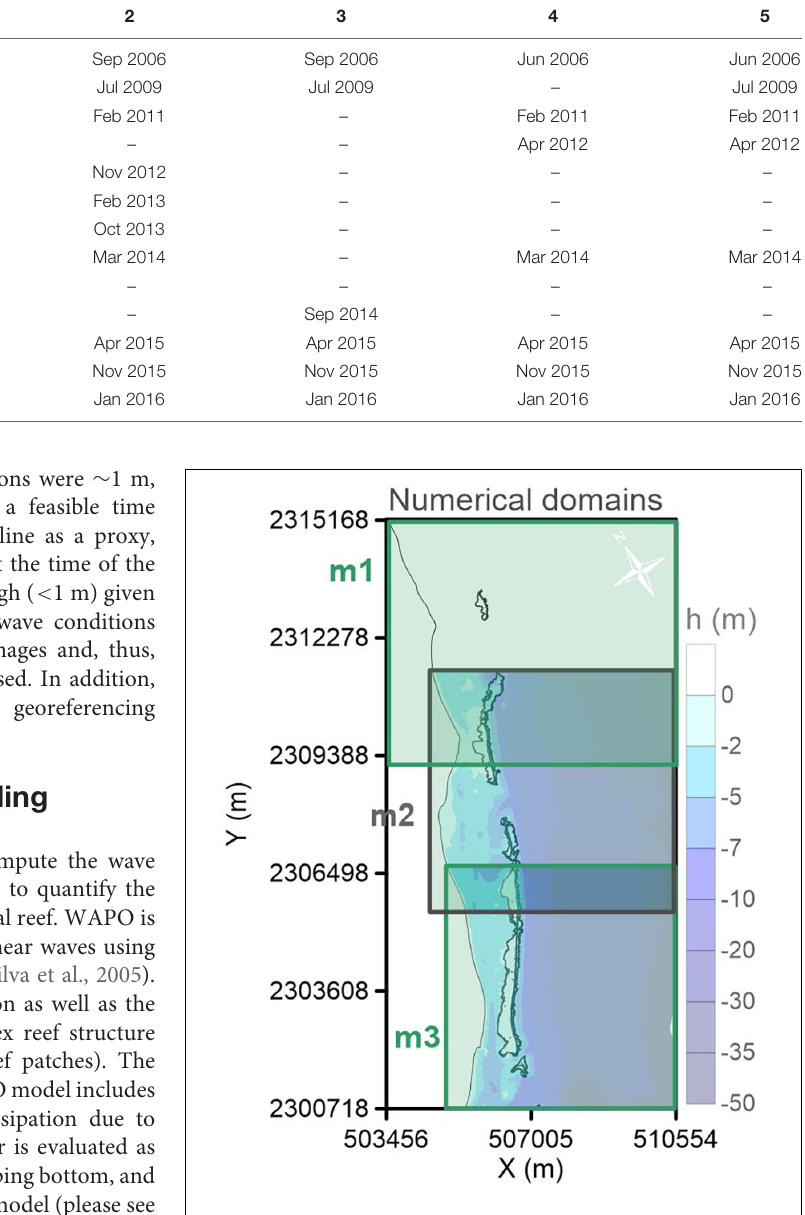
FIGURE 4 | Bathymetry and numerical domains for the wave propagation model.